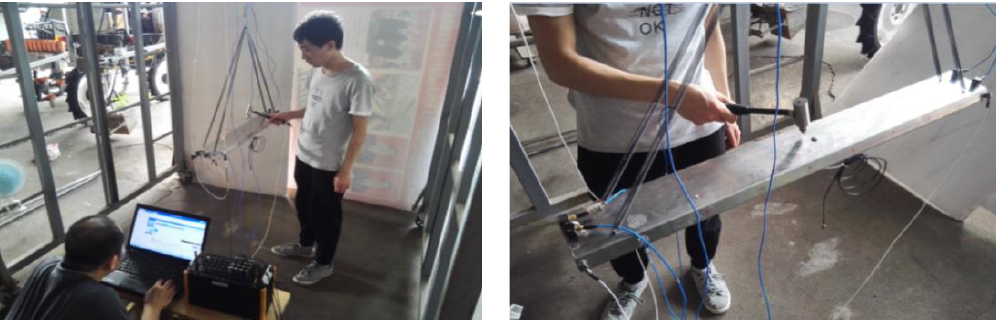
Figure 5. Experimental modal analysis process and method.